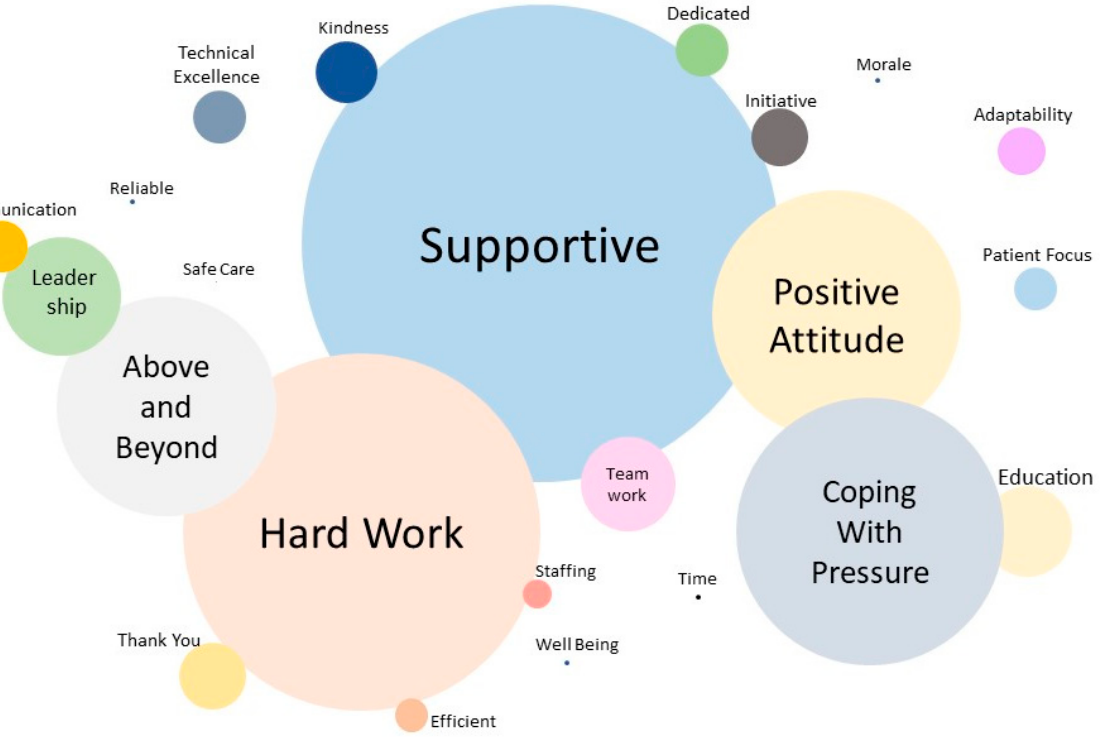
Figure 2. Chart of LFE theme category distributions, where the size of a bubble denotes the number of occurrences of each text item for a particular theme category. Note that the position of the bubbles is synthetic, solely used to portray that overlap occurs between themes.